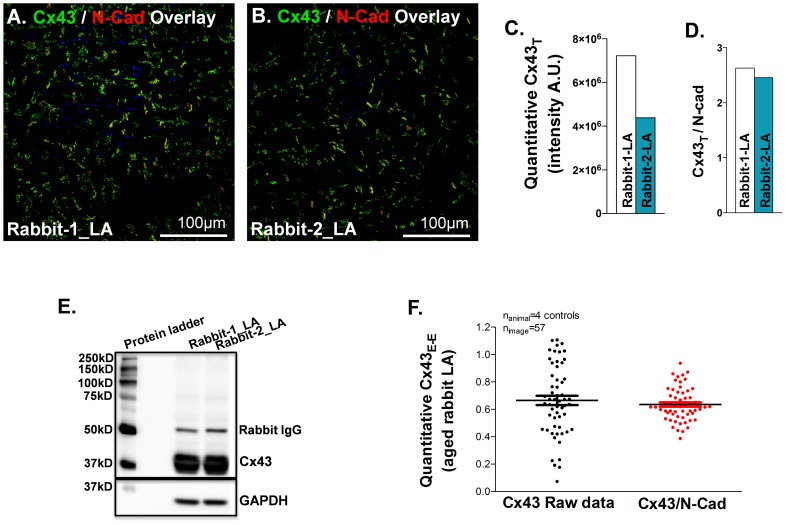
Using N-Cad as an internal housekeeping reference for imaging quantification.
A-B. Confocal images of Cx43 (green) and N-Cad (red) double immunostaining on two LA tissue sections obtained from two young rabbits (Rabbit-1 and Rabbit-2). C. Difference of quantitative total Cx43 raw data between the two confocal images obtained from Rabbit-1 and Rabbit-2 LA. D. A comparable amount of total Cx43 between the two rabbit LA samples when Cx43 raw data was normalized to N-Cad. E. Immunoblotting image of total Cx43 and GAPDH protein expression in Rabbit-1 and Rabbit-2 LA tissue homogenates. F. Comparison of quantitative immuno-stained Cx43 signal intensity with or without N-Cad normalization in aged rabbit LA.